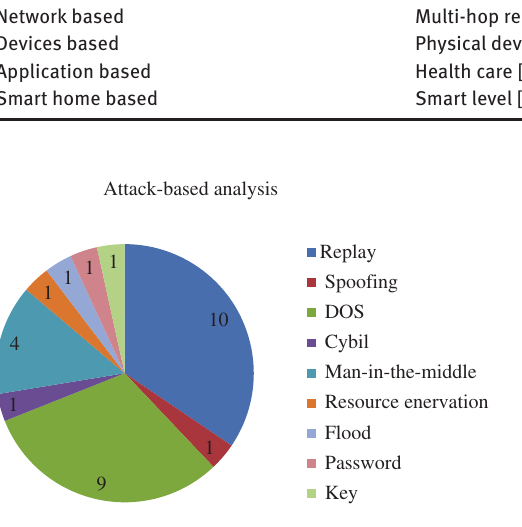
Figure 3: Pie Chart Based on